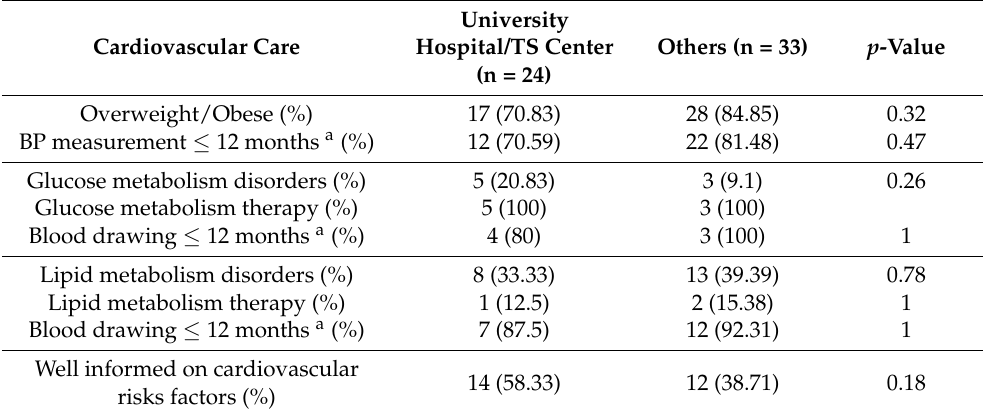
Table 5. Cardiovascular care of TS women at cardiometabolic risk in